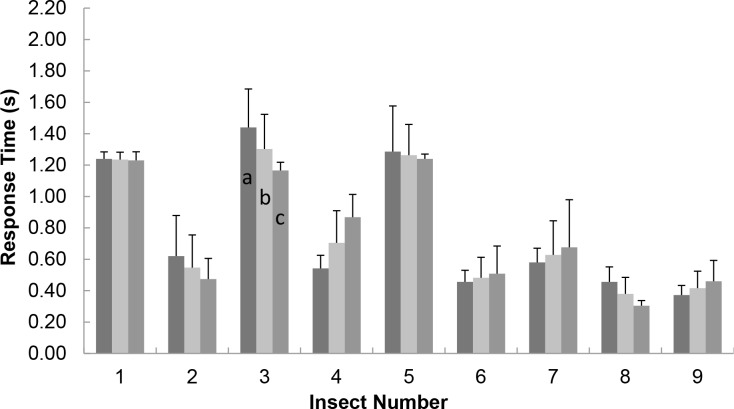
Response time of flight initiation.For each tested beetle, the (a) left, (b) middle, and (c) right columns indicate the average response times of the first 5 trials, all 10 trials, and the last 5 trials, respectively. The bar in each graph indicates the standard deviation.